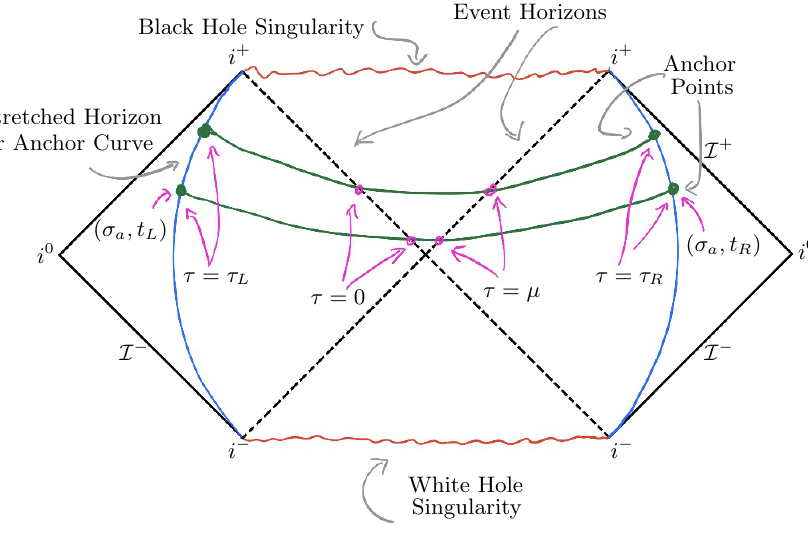
Figure 1 . This cartoon depicts the Penrose diagram of a two-sided eternal CGHS black hole. (where x + < 0 and x (cid:0) > 0) is given by x (cid:6) = (cid:7) e (cid:7) t + (cid:27) . With these conventions, the metric in ( t; (cid:27) ) coordinates approaches the two-dimensional Minkowski metric as (cid:27) ! + 1 on both sides of the black hole and t propagates to the future in the ‘upward’ direction on both